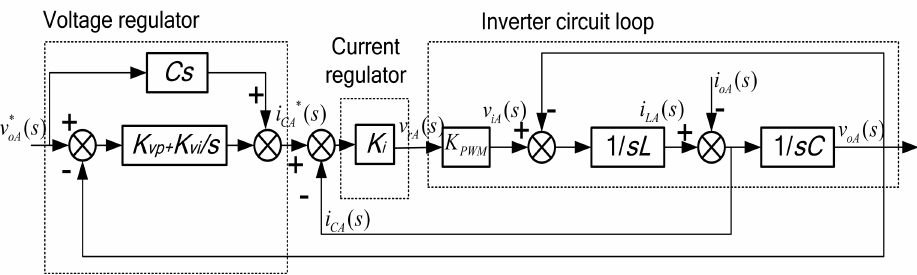
Figure 6. Double closed loop control strategy block